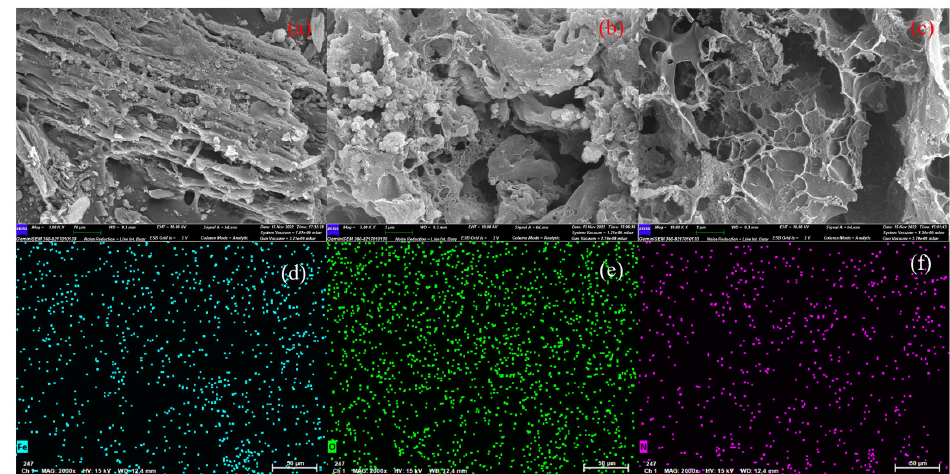
Molecules 2023 , 28 , x Figure 3. The morphology the BAC. (a – c ) SEM images of BAC; ( d ) Fe; ( e ) O; ( f ) N. Figure 3. The morphology the BAC. ( a – c ) SEM images of BAC; ( d ) Fe; ( e ) O; ( f ) N.